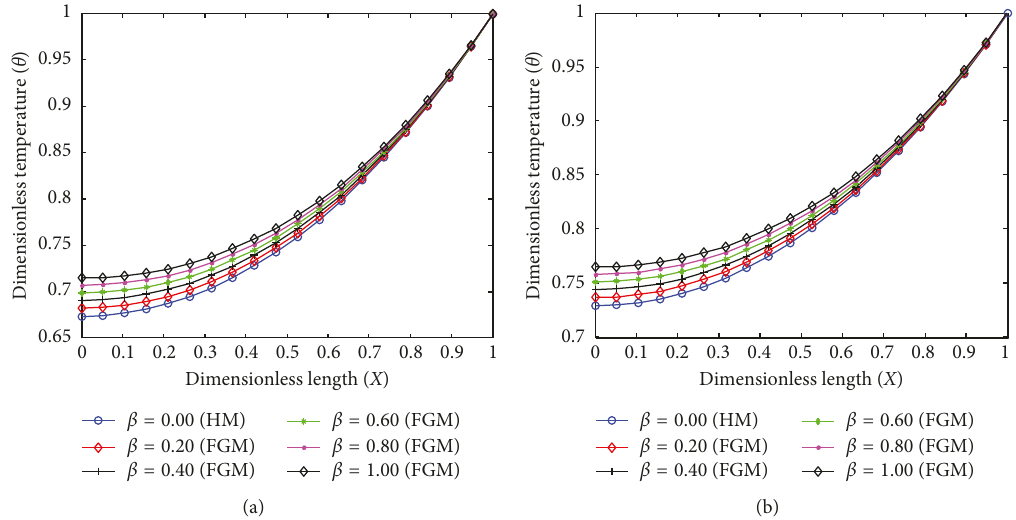
Figure 8: Temperature distribution in the fin for varying thermogeometric parameter under (a) linear-law function and (b) exponential-law